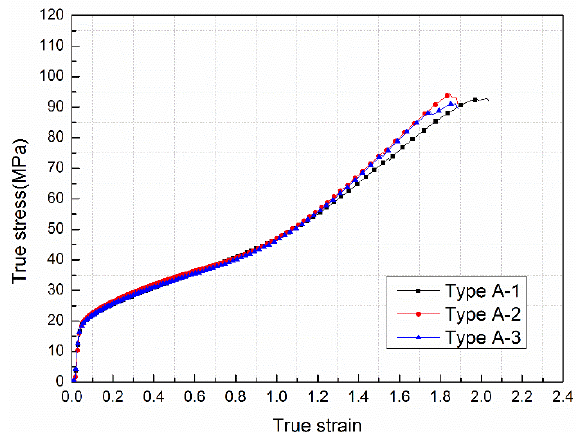
Figure 5. The true stress-strain curves for the type A specimen from triplicate experiments.